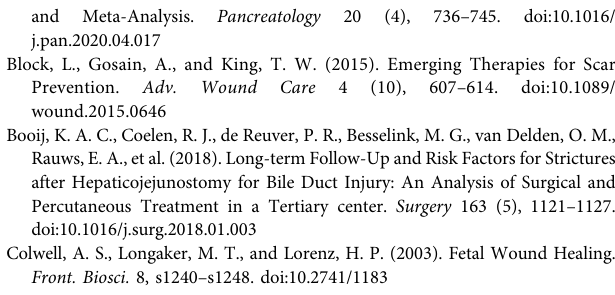
Frontiers in Pharmacology |